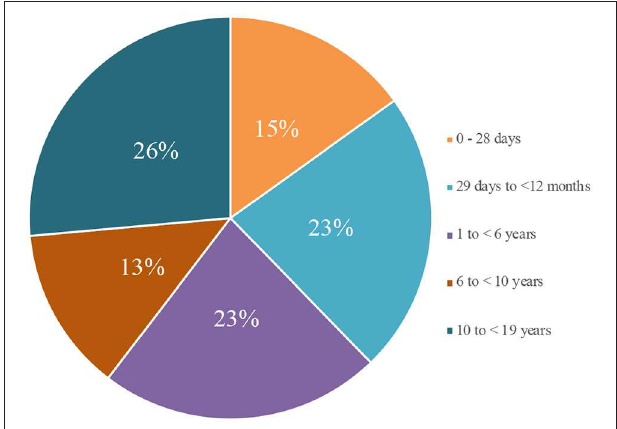
FIGURE 1 | Age distribution among pediatric confirmed COVID-19 cases